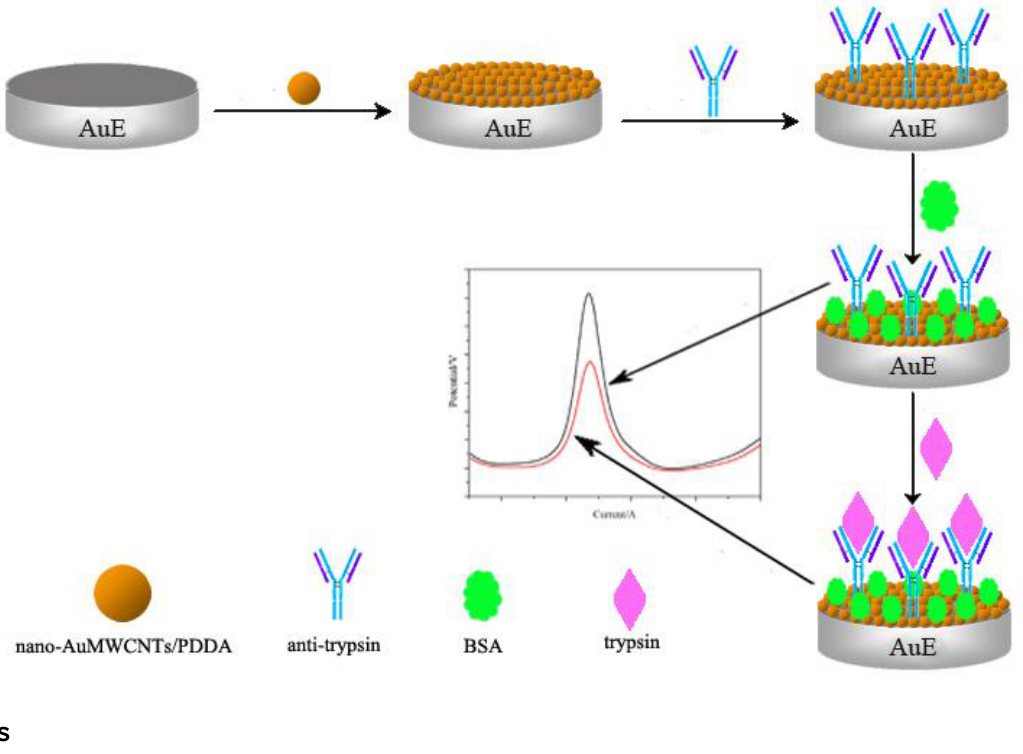
Figure 1. The preparation and assembly procedure for generating the